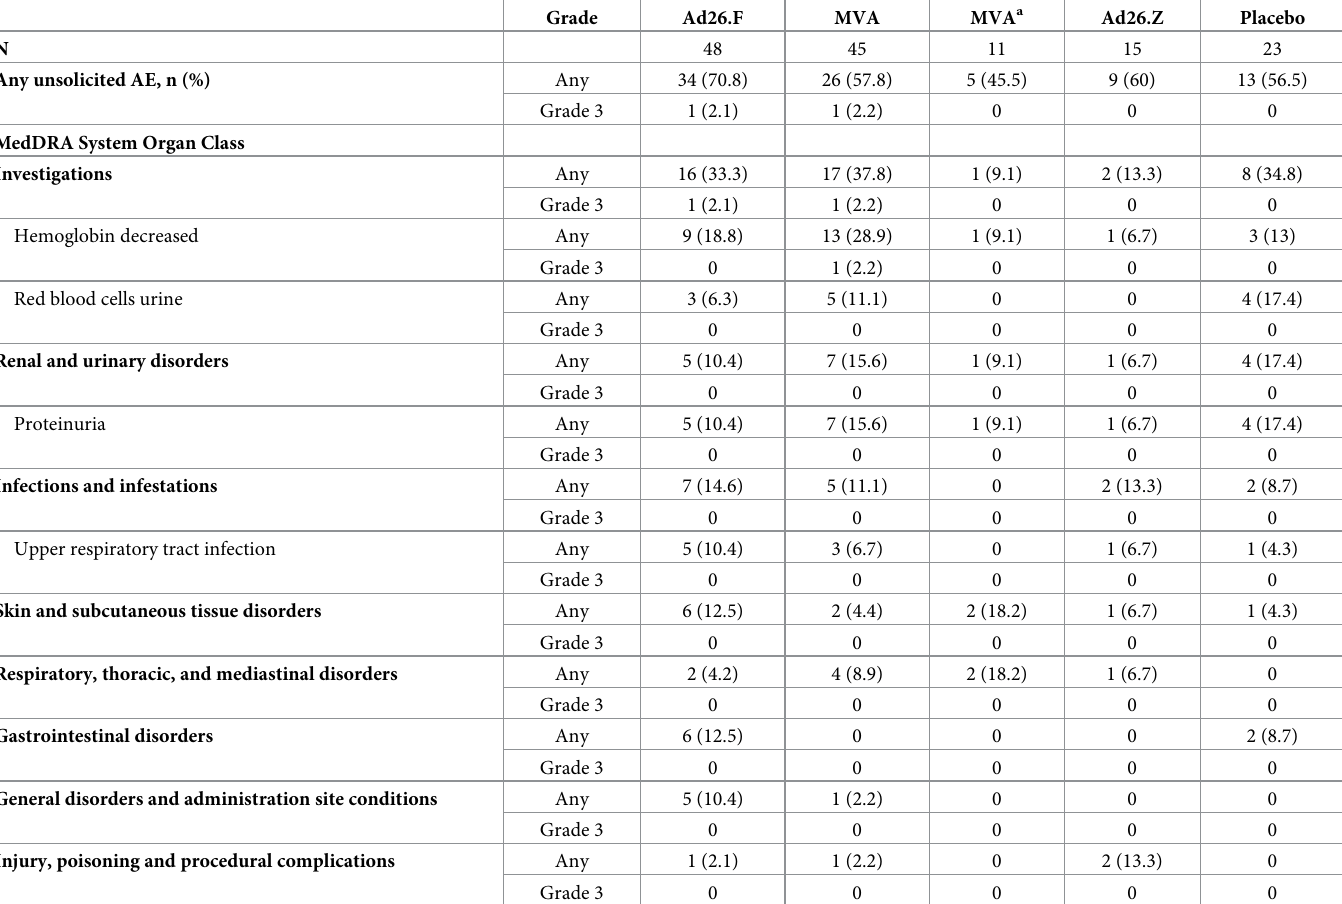
Table 3. Unsolicited AEs most frequently reported, by system organ class and dictionary-derived term (reported by � 10% participants in any regimen) by dose; full analysis